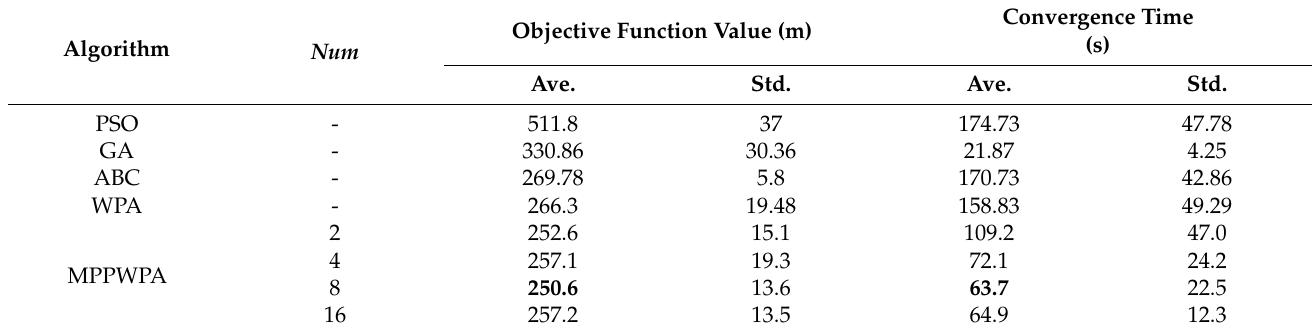
Table 7. Objective function value and convergence time with different Num in scenario 2.